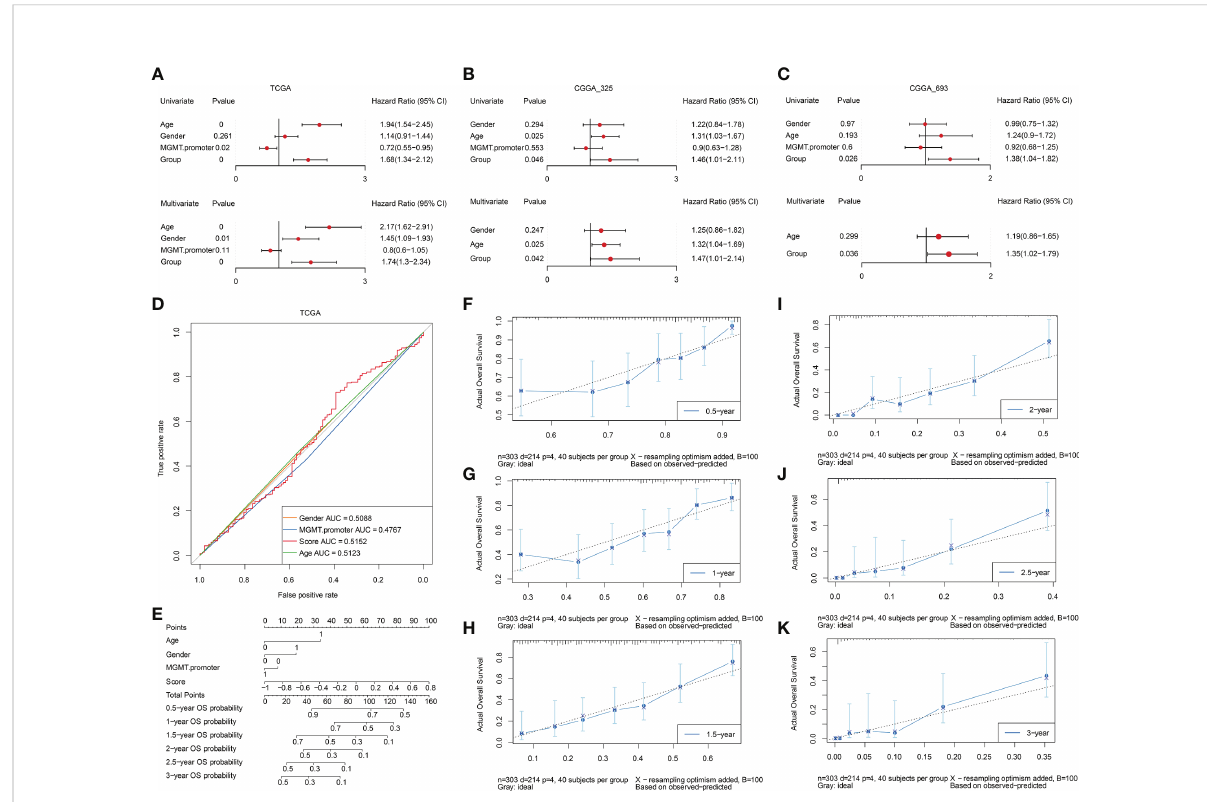
FIGURE 11 Assessment of independent ef fi cacy of the prognostic model. A-C. Univariate (upper panel) and multivariate (lower panel) Cox regression analysis of the prognostic model and clinical features in the TCGA (A) , CGGA_325 (B) , and CGGA_693 (C) datasets, respectively. (D) Nomogram for predicting the prognosis of GBM patients, integrating three clinical features and the prognostic model we established. (E) Multi-ROC curves for predicting 0.5-year, 1-year, 1.5-year, 2-year, 2.5-year, and 3-year OS for GBM patients based on three clinical features and the prognostic model. F-K. The calibration curves of the nomogram model for predicting GBM patients ’ 0.5-year (F) , 1-year (G) , 1.5-year (H) , 2-year (I) , 2.5-year (J) , and 3-year (K)